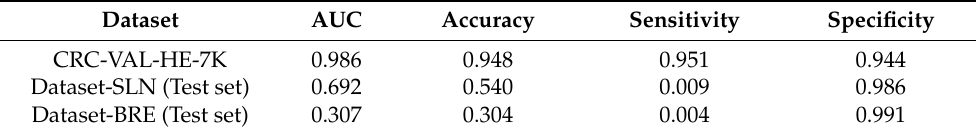
Table 5. The results of source domain for identifying CRC, breast cancer and sentinel lymph node metastasis. Dataset AUC Accuracy Sensitivity